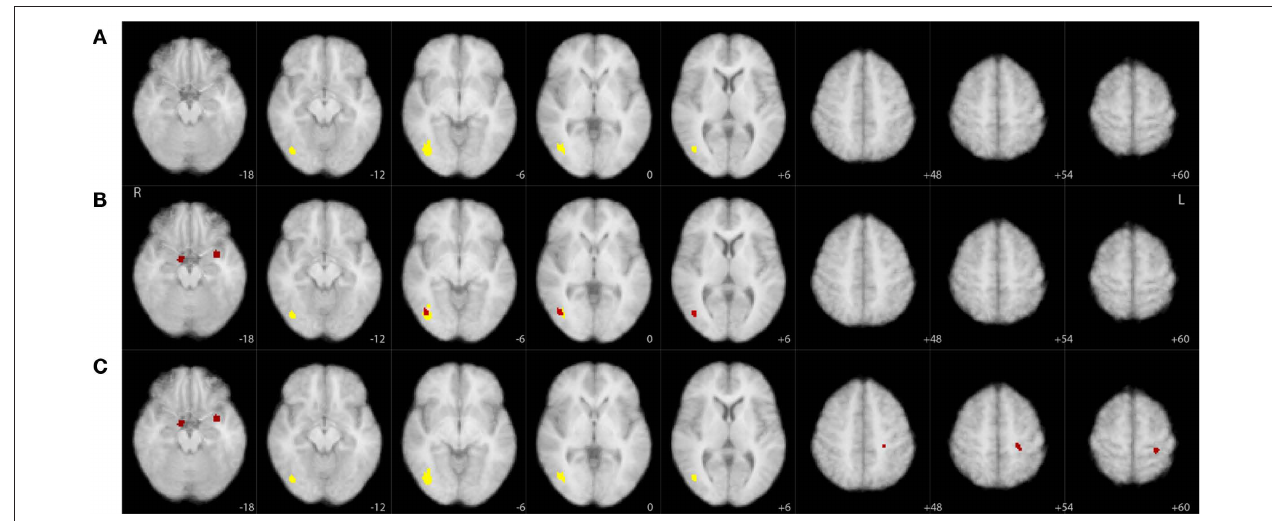
FIGuRE 6 | Significant clusters (yellow, p < 0.01; red, p < 0.05) overlaid on axial slices of an MNI template brain image. Each row corresponds to a different thresholding technique derived from our resampling tests: (A) cluster size only based